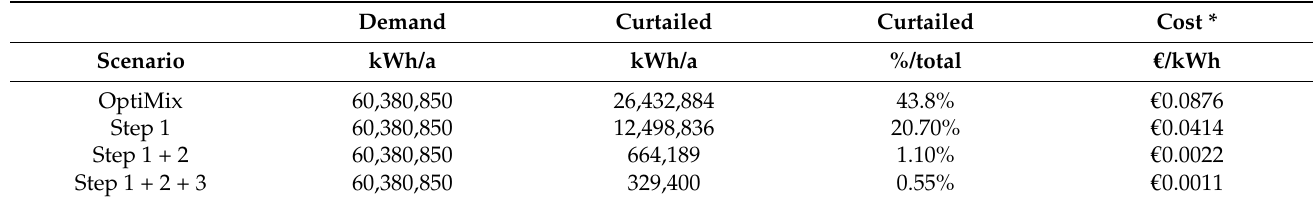
Table 13. Effects of curtailment on the optimization scenarios.